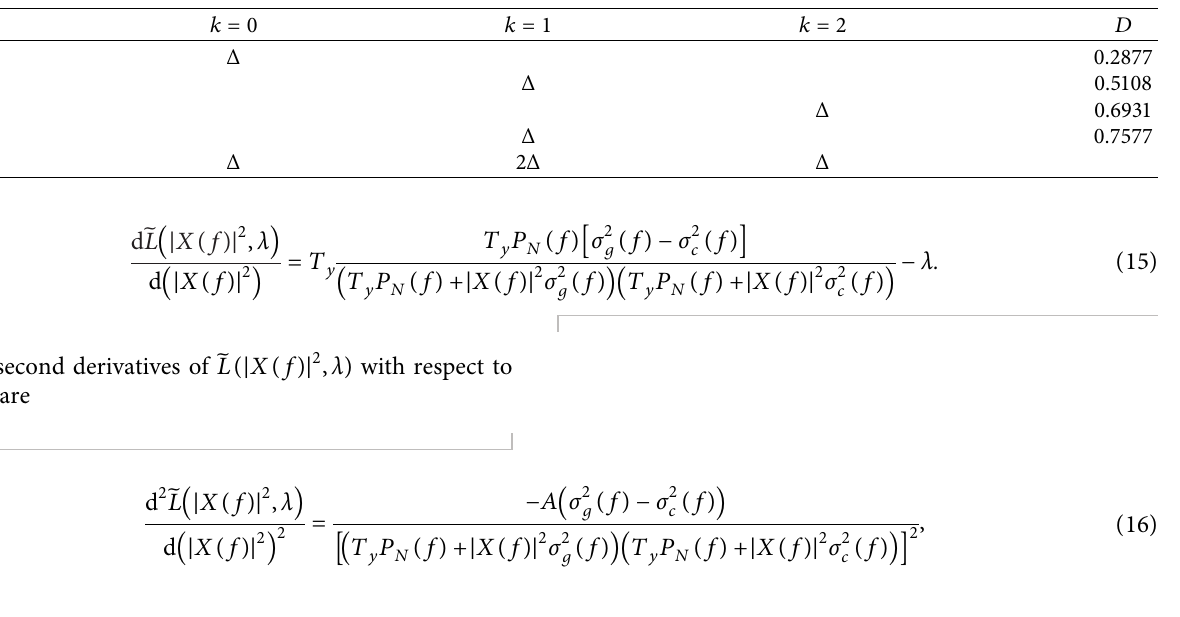
Table 5: Final allocation of